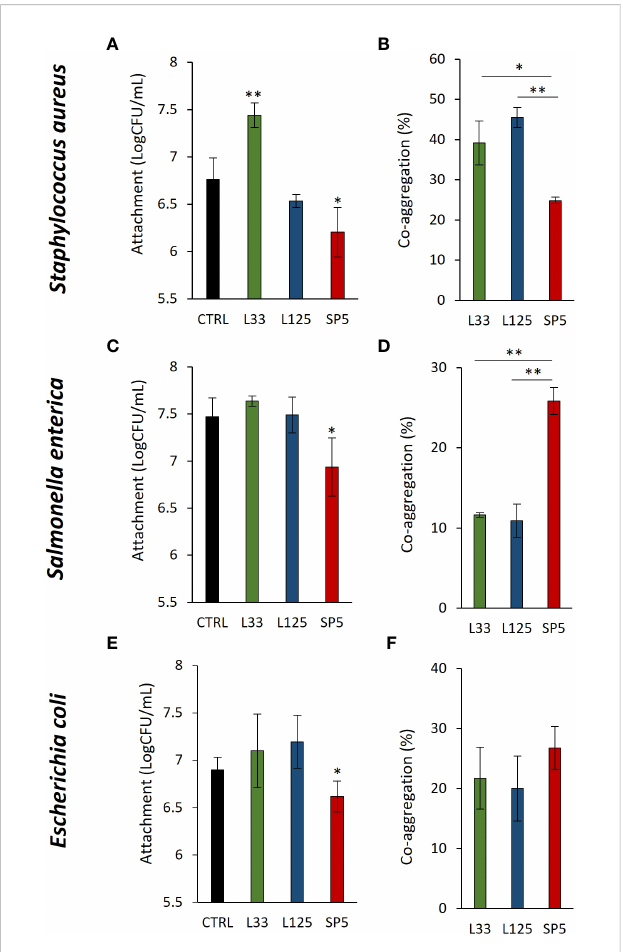
FIGURE 2 Competitive exclusion and co-aggregation capacity of the lactobacilli with the pathogens. (A, C, E) Competition between the live lactobacilli and (A) S. aureus , (C) S. enterica or (E) E. coli for attachment on the human colon adenocarcinoma cell line, HT-29, after 4 h of co- incubation. Results are expressed as the mean ± standard deviation of three independent experiments. * p < 0.05 compared to untreated control. (B, D, F) Investigation of the co-aggregation capacity of lactobacilli with pathogens after 4 h co-incubation in suspension. Results are expressed as the mean ± standard deviation of three independent experiments. * p < 0.05, ** p <